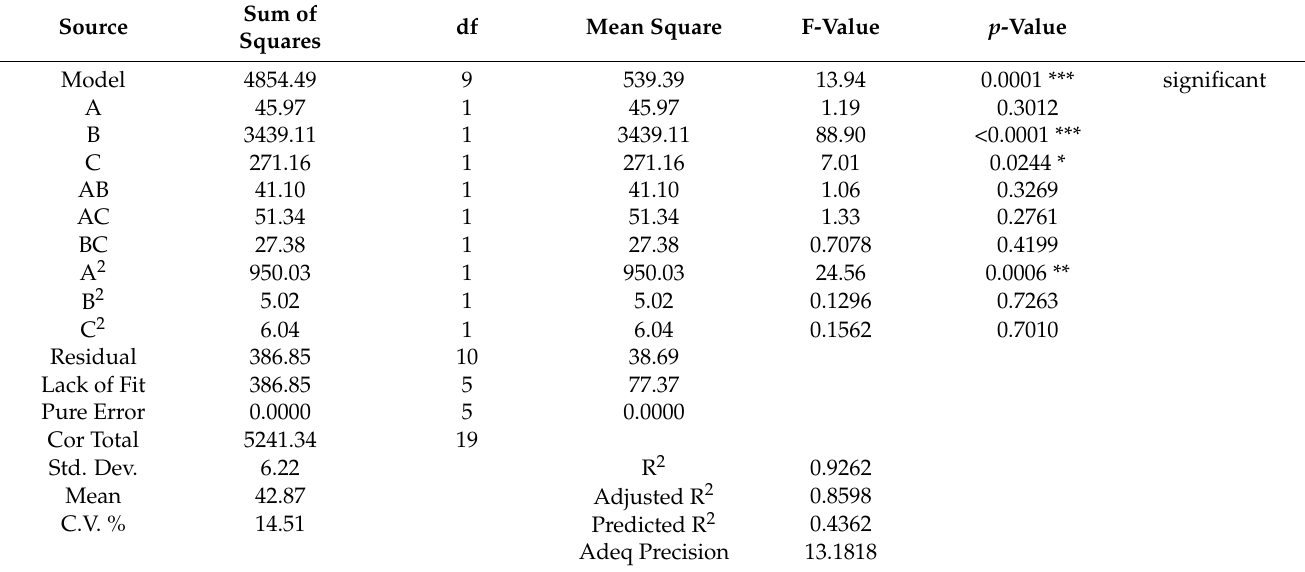
Table 4. ANOVA output for CCD model identifying factors and interactions significantly affecting the diesel